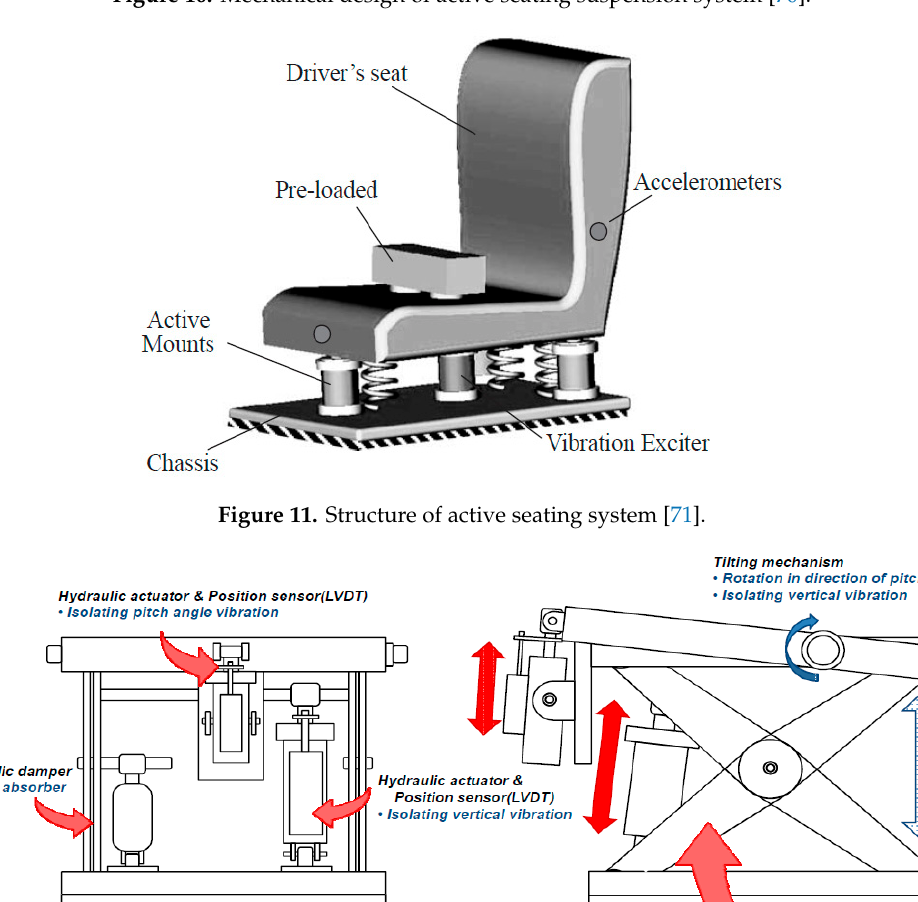
Figure 10. Mechanical design of active seating suspension system [70].